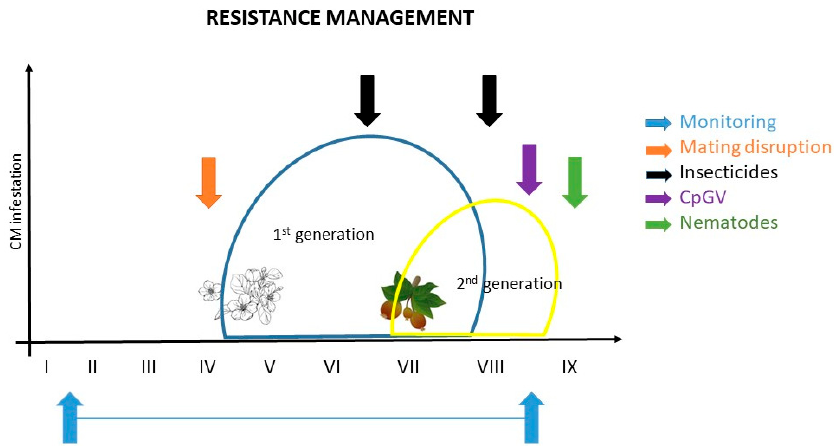
Figure 1. Example of resistance management for codling moth; the ideal control is a combination of different measures (modified by Martina Kadoi ć Balaško).